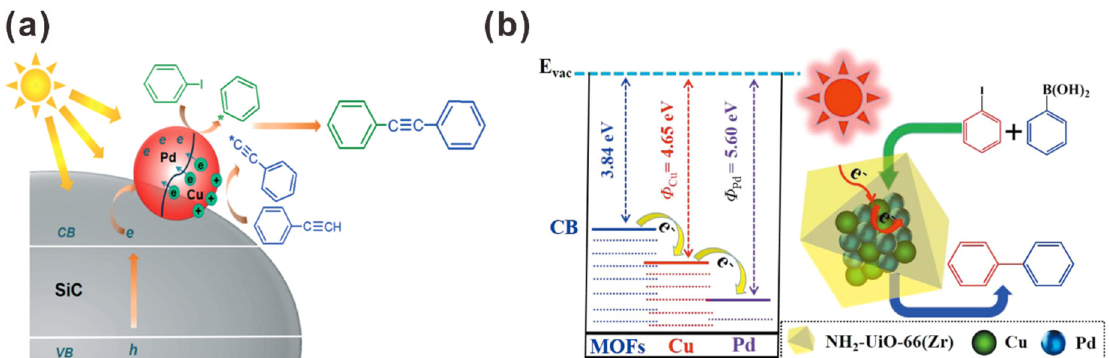
Figure 15. The schematic diagram of the proposed mechanism using CuPd bimetallic alloy for photocatalytic C–C cross- coupling. ( a ) PdCu/SiC for photocatalytic Sonogashira reaction. Reproduced with permission from Reference [144]. Copyright 2018 Royal Society of Chemistry. ( b ) CuPd@NH 2 -UiO-66(Zr) for photocatalytic Suzuki coupling. Reproduced with permission from Reference [145]. Copyright 2018 Wiley-VCH.